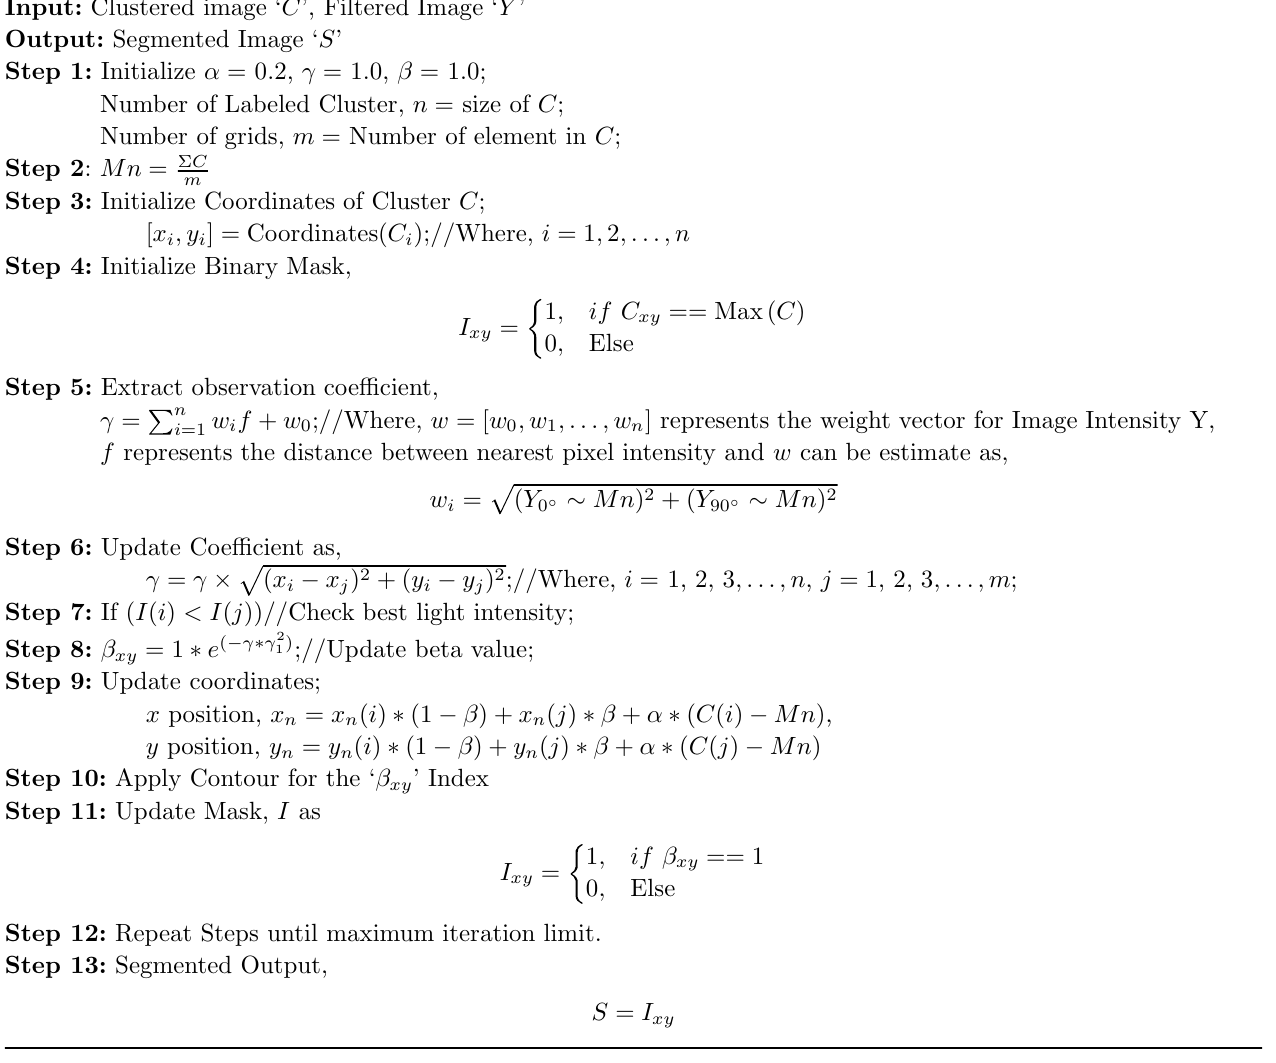
Algorithm 3. Intensity Variation